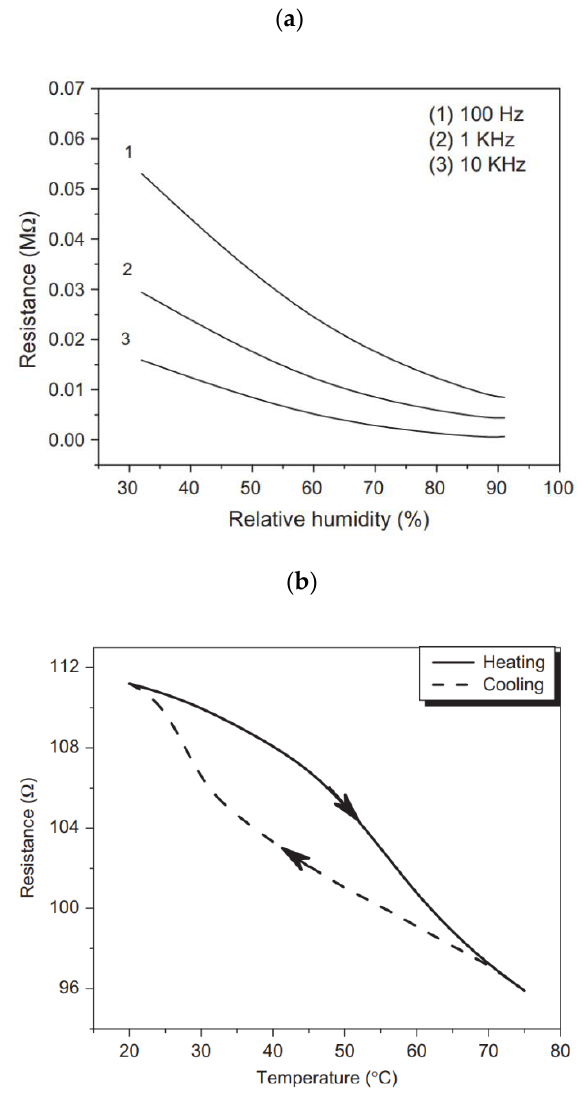
Figure 20. ( a ) Resistance-relative humidity relationships of the Ag/CNT/NiPc/PEPC/Au humidity sensor based on sorted SWCNTs. ( b ) Resistance–temperature relationships of one of the CNT-film- based sensors in heating–cooling processes [140]. Copyright 2011, with permission from Elsevier.